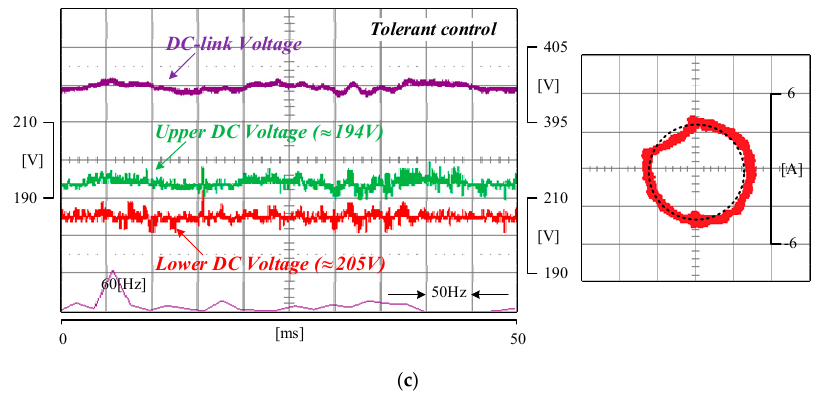
Figure 15. DC-link voltages and X-Y plot of the three-phase input currents. ( a ) Healthy condition; ( b ) open-switch fault ( S a 2 ) condition; ( c ) Proposed fault-tolerant control method.